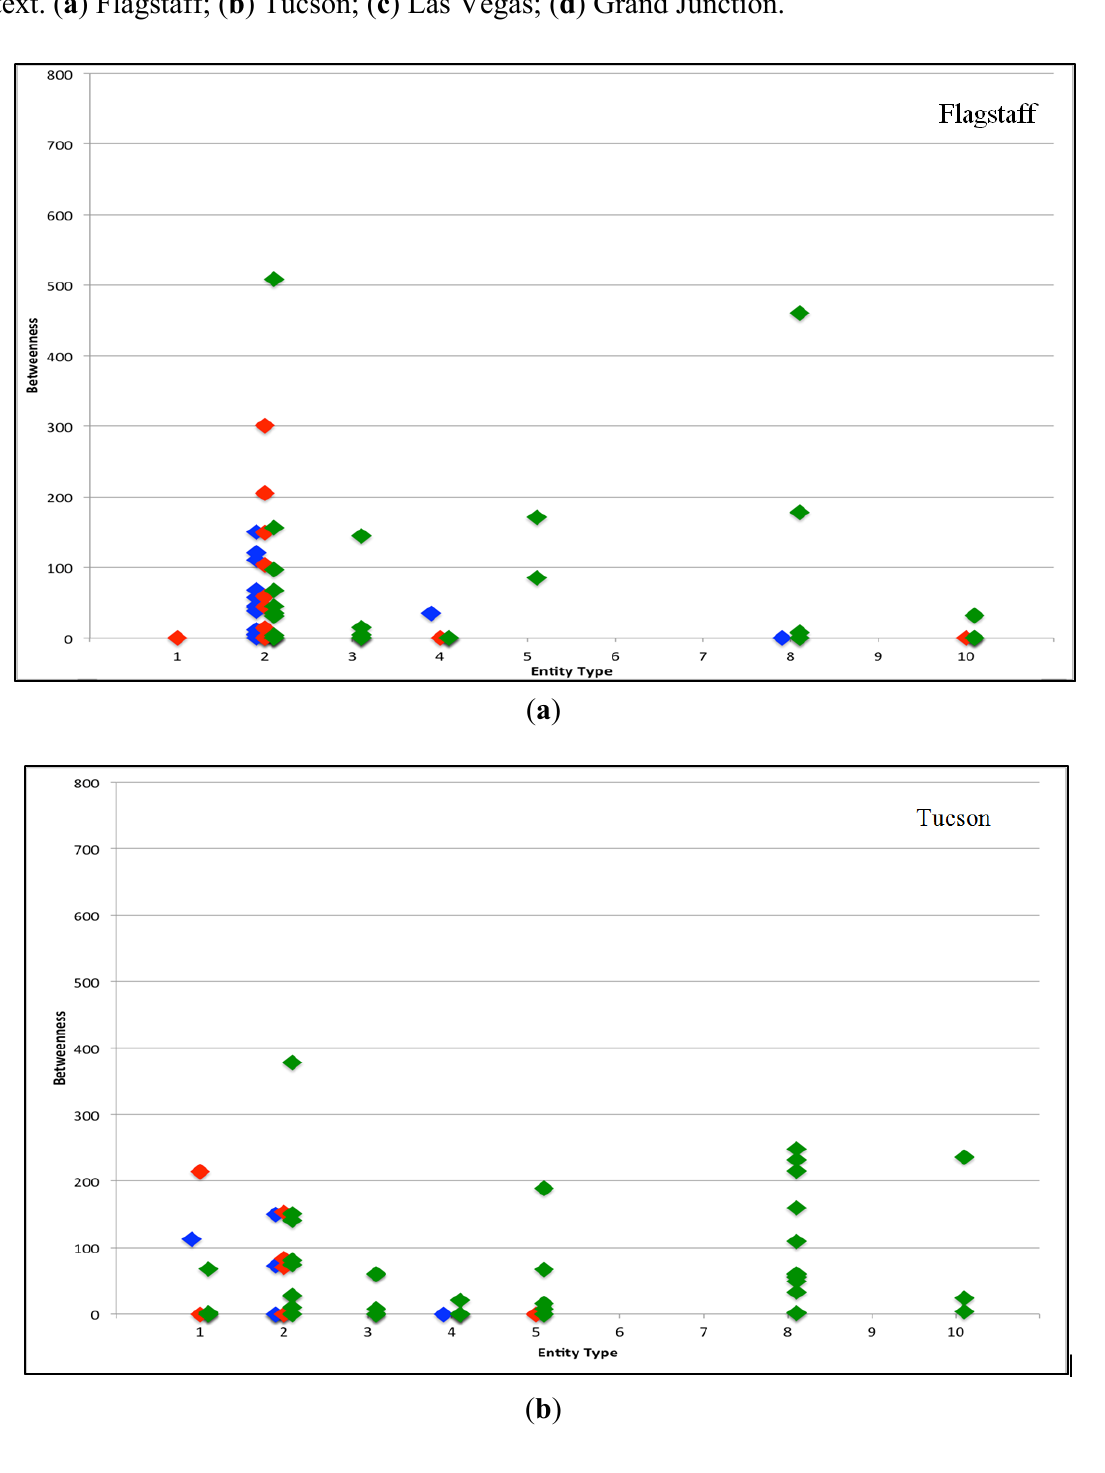
Figure 6. Distributions of betweenness centrality, by type and level of entity, from Step 2 results. Blue = federal; red = state; green = local. Categories 1–10 are as given in the